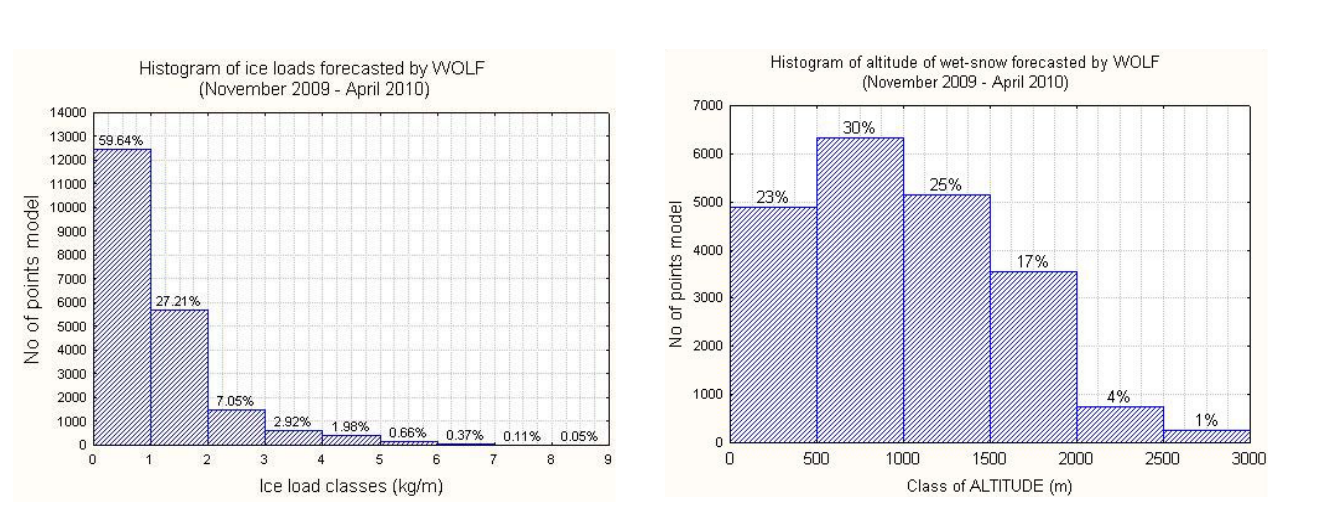
Fig. 11. Ice load frequency for the WOLF domain. Fig. 12. Ice load frequency for the WOLF domain, divided into range of